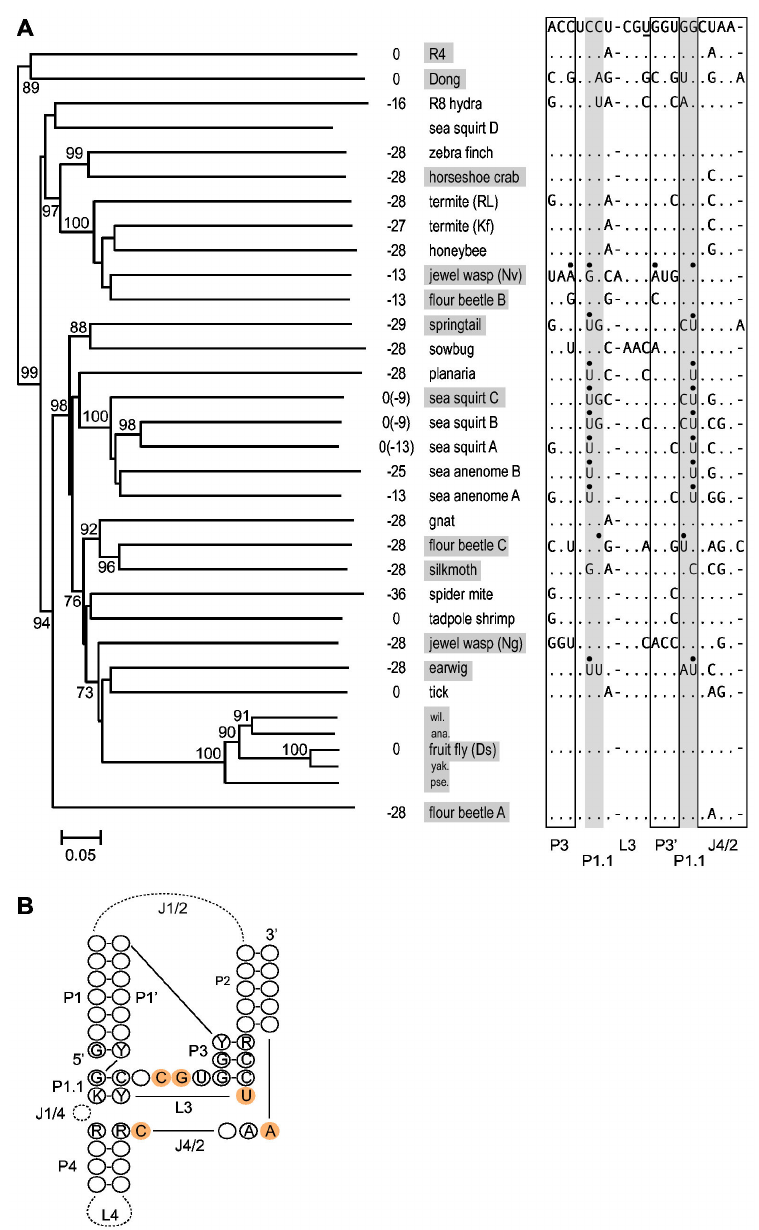
Figure 6. R2 element phylogeny and its correlation with cleavage location and ribozyme sequence. (A) Best tree based on the neighbor-joining method and rooted using the retrotransposons Baggins1 and L1Tc. Most elements are listed in Figure 2 and Supporting Information, Figure S2. Additional fruit fly elements include: D. willistoni (wil.), D. ananassae (ana.), D. yakuba (yak.), and D. pseudoobscura (pse.). Bootstrap values above 70% are shown. Numbers left of the elements are predicted or demonstrated (boxed elements) self-cleavage locations relative to the R2 insertion site. The 5' junction cleavage site agrees with previous predictions for sea squirt A, tick, and R4; however, the tadpole 5' end is shifted 1 nucleotide and 28S cleavage sites are suggested for zebra finch, gnat, and both termites [12]. The 5' end of the sea squirt D element could not be folded and may be incomplete. To the right of each element are sequence differences in the ribozyme active site relative to the R2 consensus sequence (top line). The underlined 'U' in this consensus is a 'C' in the HDV antigenomic ribozyme. Black dots indicate nucleotides that disrupt P3 or P1.1 stem pairing. (B) Consensus structure of the R2 ribozymes based on 26 elements (additional fruit fly elements were not included) in panel (A). Length differences and mismatches in the P1, P2, and P3 stems are described in the text. Nucleotides present in at least 75% of the R2 ribozymes are indicated. Invariant nucleotides are shaded orange. The sow bug ribozyme, which does not show activity in vitro , has 'C' to 'A' and 'G' to 'A' differences at the conserved sites in L3. Y= U or C; R= A or G; K= G or U. doi: 10.1371/journal.pone.0066441.g006 PLOS ONE |